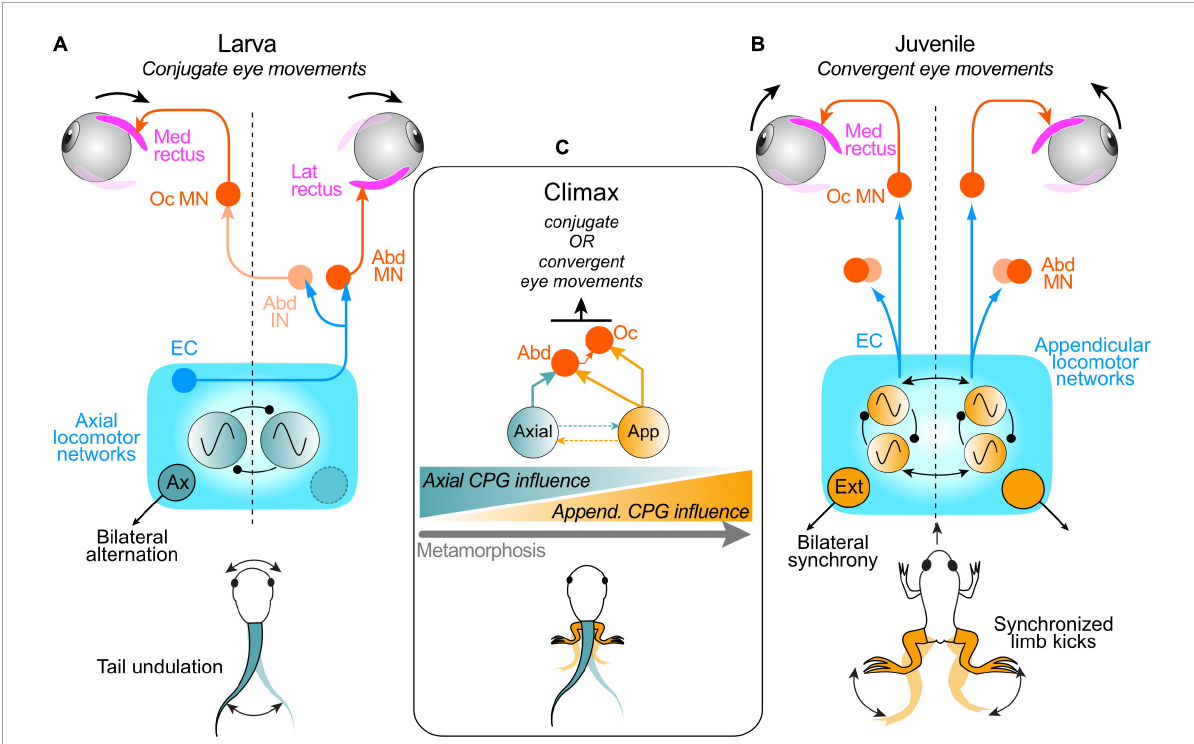
FIGURE3 Neuronal pathways underlying spino-ocular motor coupling during swimming in pre- and post-metamorphic Xenopus . (A) Schematic depicting the spinal CPG for tail-based propulsion in larvae and pathway connections that convey spinal EC signals to the extraocular motor system; after crossing the spinal cord, ascending projections from the spinal axial CPG network directly drive abducens motoneurons (Abd MN) innervating the lateral rectus (LR) eye muscle on the opposite side and indirectly via abducens internuclear neurons (Abd IN) drive oculomotor motoneurons (Oc MN) innervating the synergistic medial rectus (MR) eye muscle on the same side; this spino-ocular connectivity produces conjugate eye movements during swimming. (B) Schematic depicting the spinal CPG for limb-based rectilinear forward propulsion in juvenile Xenopus and pathway connections with the extraocular motor system; ascending, uncrossed projections from the spinal appendicular locomotor network activate ipsilateral Abd MNs and Oc MNs to produce convergent eye movements during each hindlimb extensor-driven kick cycle. (C) During metamorphic climax, larval and adult CPG circuits co-exist and can be conjointly active, producing a combination of tail- and limb-based propulsion and corresponding EC signals that continuously elicit appropriate conjugate and convergent eye movements; the influence of the appendicular system on ocular motor control progressively increases as the impact of the axial system declines as limb-based locomotion emerges, co-exists with, and eventually replaces tail-based locomotion during metamorphosis (schematized at